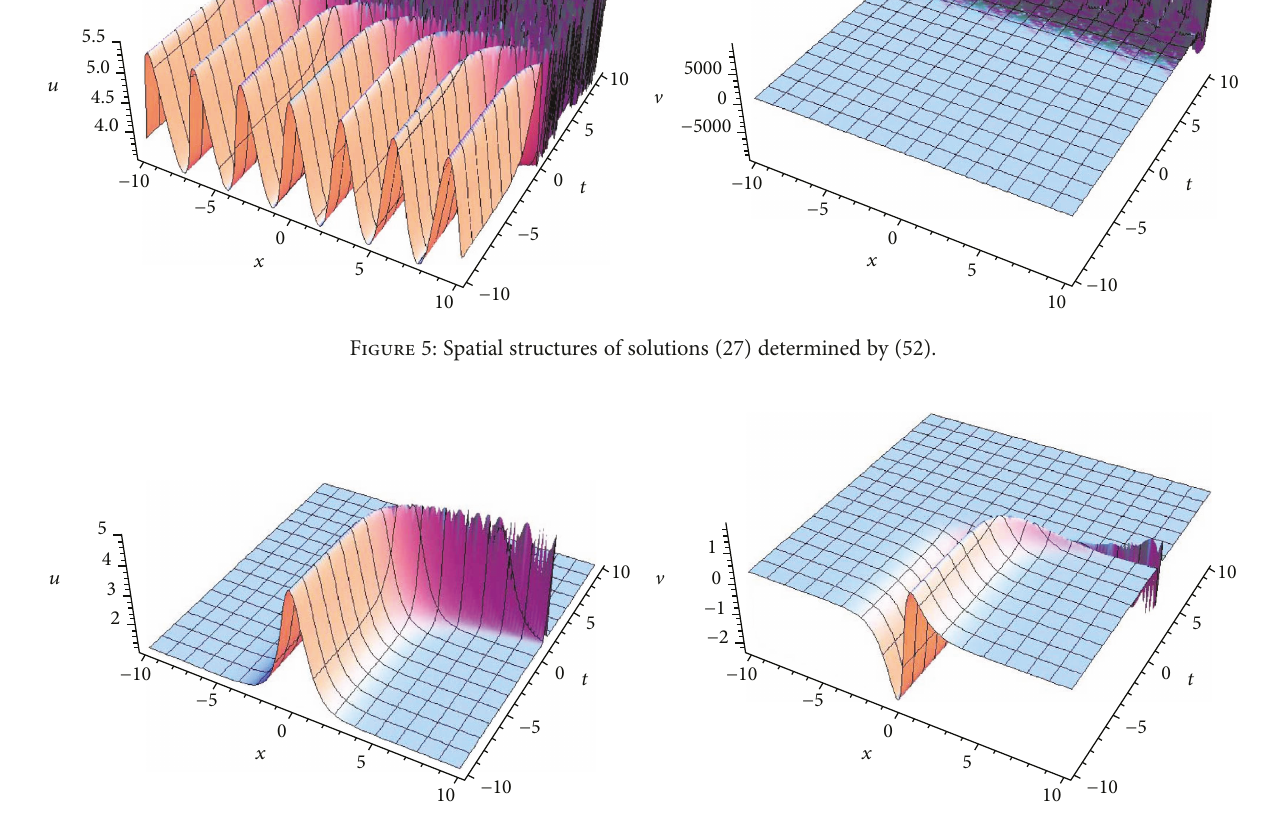
Figure 6: Spatial structures of solutions (40) determined by (52) given m = 1